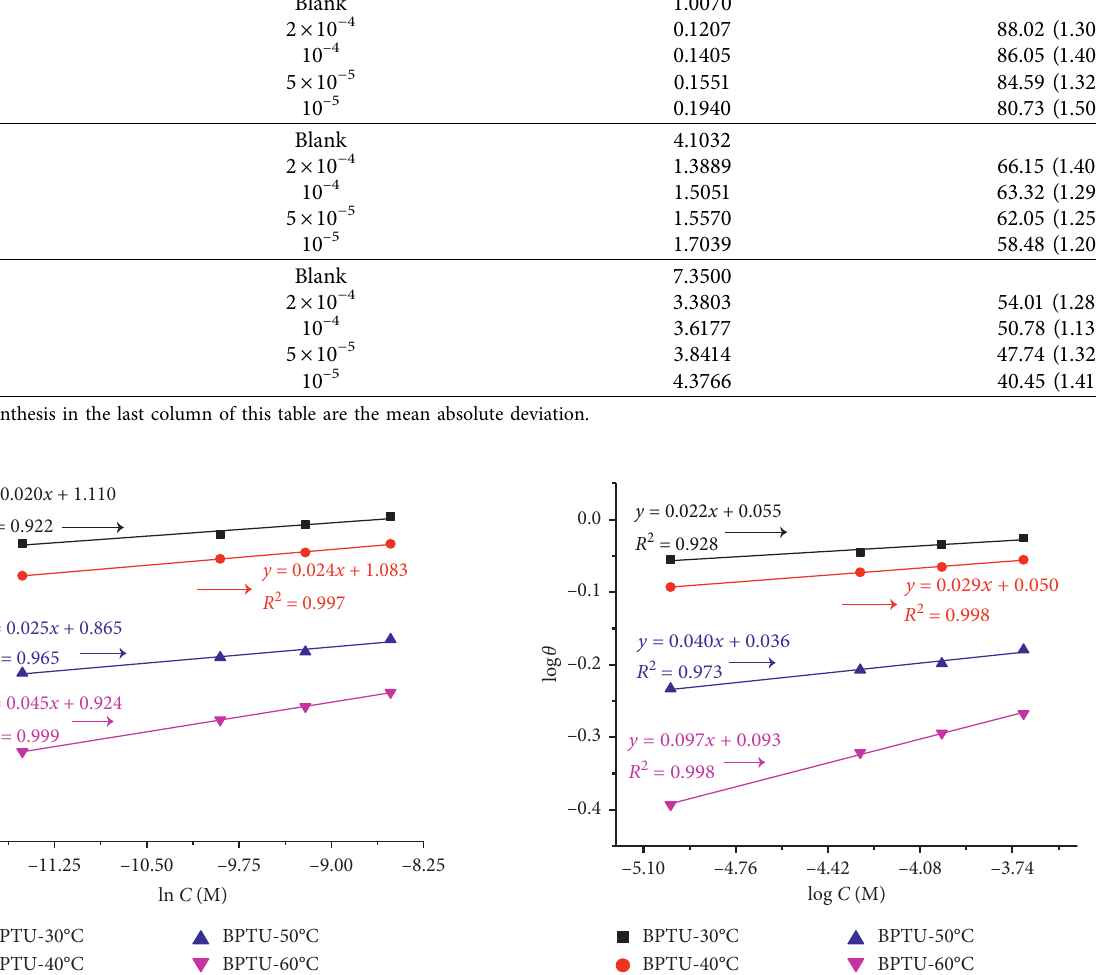
Figure 10: Freundlich’s adsorption isotherm of BPTU on the steel surface in 1.0M